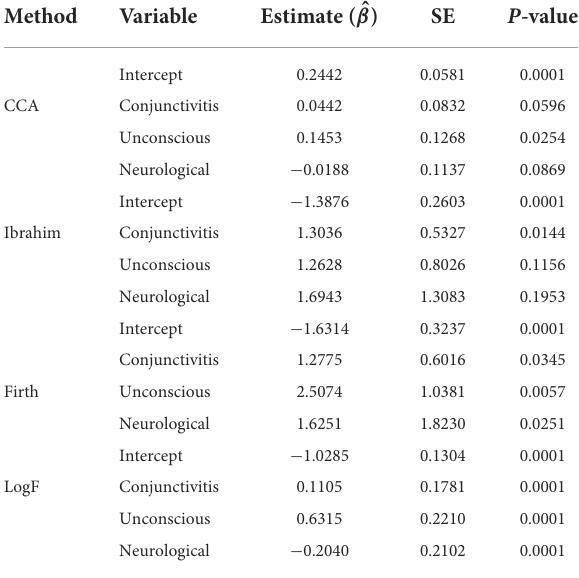
the complete case analysis (CCA) and Ibrahim’s method each indicate only one different significant parameter, smaller SEs under the CCA than the Ibrahim’s